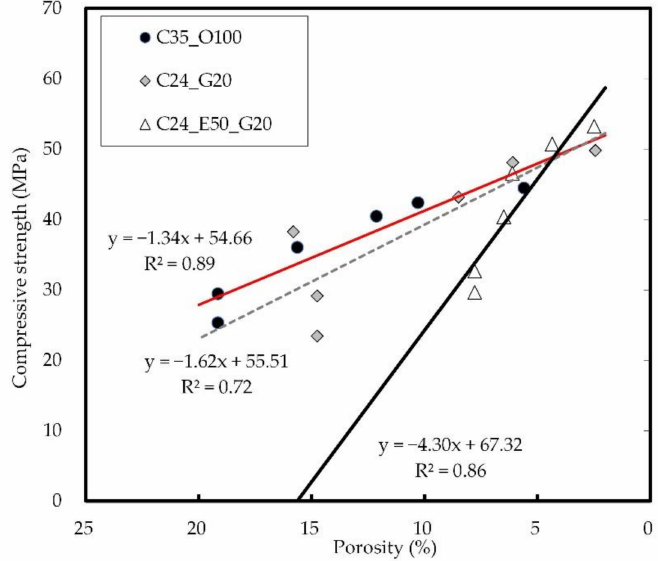
Figure 14. Relation between internal porosity and compressive strength on